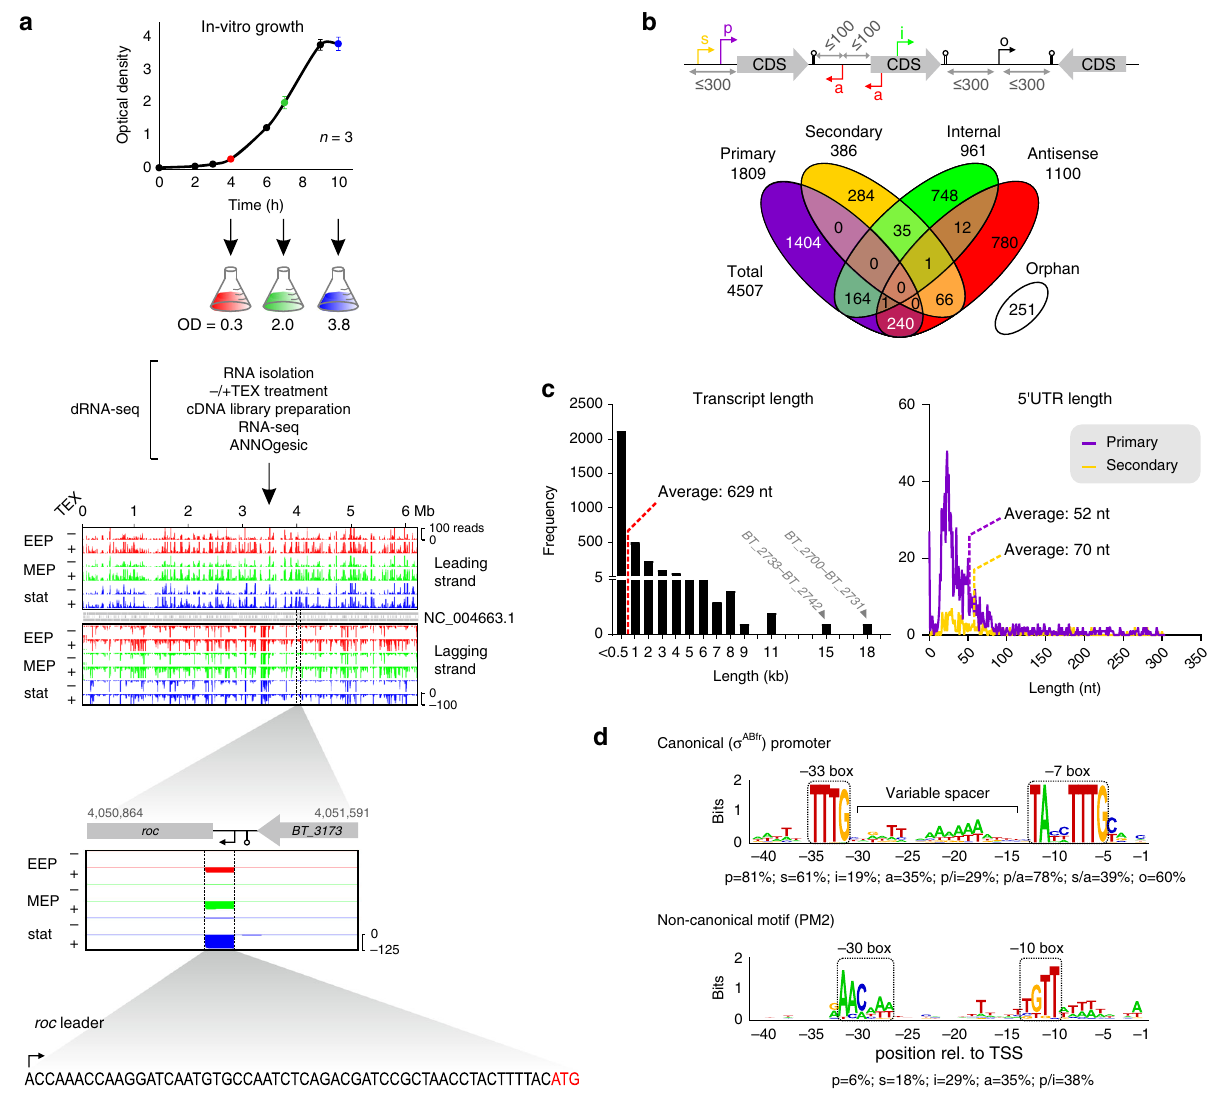
Fig. 1 High-resolution view at the B . thetaiotaomicron transcriptome. a Experimental work fl ow of the dRNA-seq approach and close-up view on the transcription start site (TSS; indicated by a bent arrow) of the regulator of colonization ( roc ) gene. Bacteria (AWS-001) from three different growth phases in TYG medium — early exponential (EEP), mid-exponential (MEP), and stationary phase (stat) — were analyzed. TEX, terminator exonuclease. Growth data refer to the mean + / − standard deviation from three biological replicates. For the read coverage plots, one representative replicate out of three is depicted. b De fi nition of categories for TSS annotation (upper) and overlap among TSS categories (lower). CDS, coding sequence. Note that pTSS and sTSS are mutually exclusive (thus no overlap in the Venn diagram). c Length distribution of transcripts (left) and 5 ′ UTRs (right). Long operons are labeled by name. d Motif searches upstream of B . thetaiotaomicron TSSs reveal the canonical σ ABfr promoter (upper) and a second, near-palindromic motif ( ‘ PM2 ’ ; lower). Percentage values below the respective motif denote the frequency of that sequence upstream of the respective TSS category as de fi ned in b . Source data to this fi gure are provided in the Source Data fi